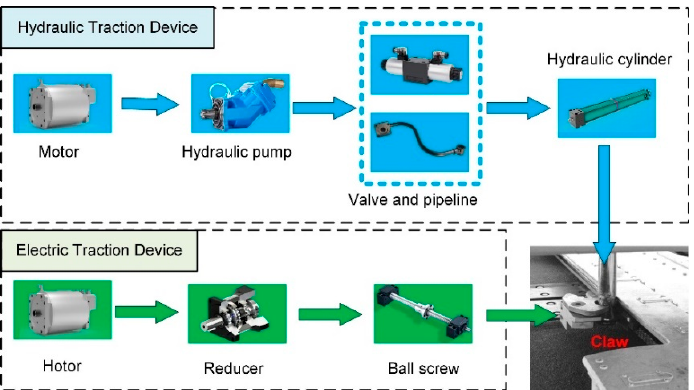
Figure 2. The energy transfer process of HTD and ETD.